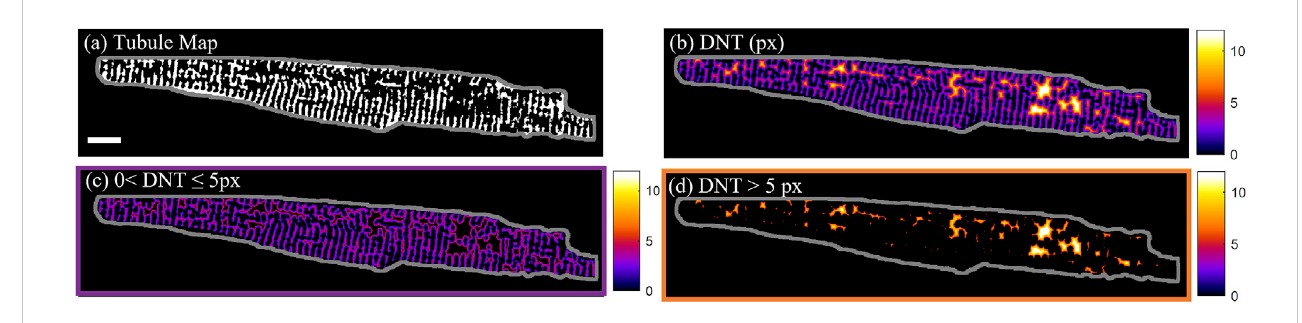
FIGURE 1 T-tubuleanddistancetonearesttubulemaps. (A) BinarytubulemapofcellDwiththecelloutlineshowningrey. (B) Pixeldistancetonearesttubule(DNT) map of cell D. (C) Tubulated regions of cell D with 0 < DNT ≤ 5 px. (D) De-tubulated regions of cell D with DNT > 5 px. Scalebar: 10